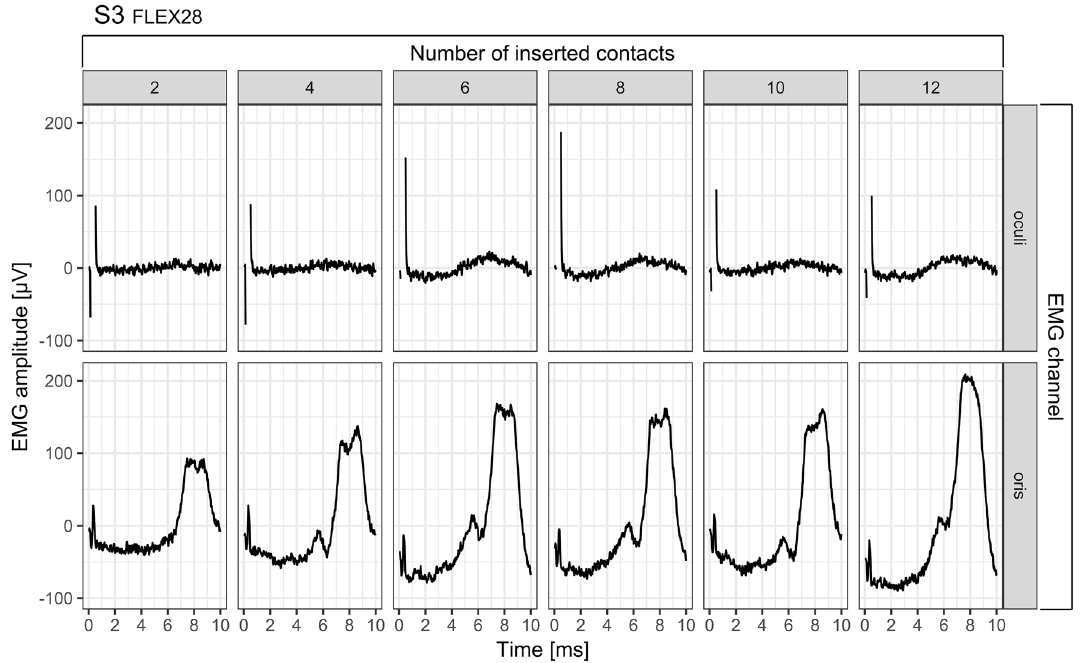
Figure 5. Example of a raw EMG recording during electrode insertion in subject S3. For each insertion step, the stimulation current level was 378 CU. The upper row shows the EMG recordings of M. orbicularis oculi, the lower row of M. orbicularis oris. The number of currently inserted contacts can be read from the number line above the graph. Each signal corresponds to the average of the EMG responses to two subsequently emitted stimulation pulses. In both EMG channels, the electrical stimulation artifact caused by the stimulation pulse can be seen at the beginning of each recording. In the case of the orbicularis oculi muscle, the artifact is several times the amplitude of the artifact of the orbicularis muscle and is therefore clipped in this